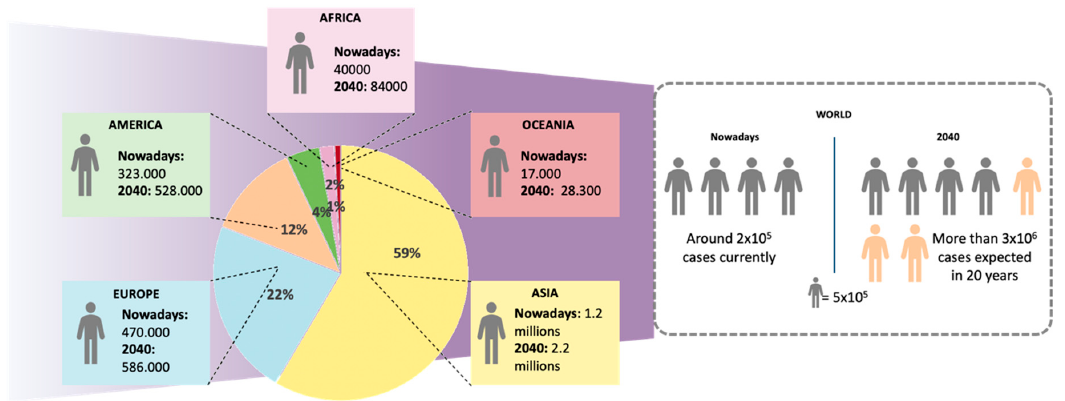
Figure 1. Lung cancer statistics nowadays. Geographical distribution of lung cancer cases and estimated number of cases worldwide in 2018 and 2040 (Source: Globocan). Table 1. Subclassification of histological heterogeneity of Non-Small Cell Lung Cancer (NSCLC).